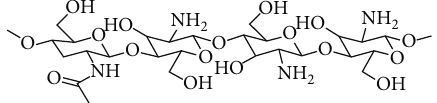
Figure 15: The chemical structure of chitosan.